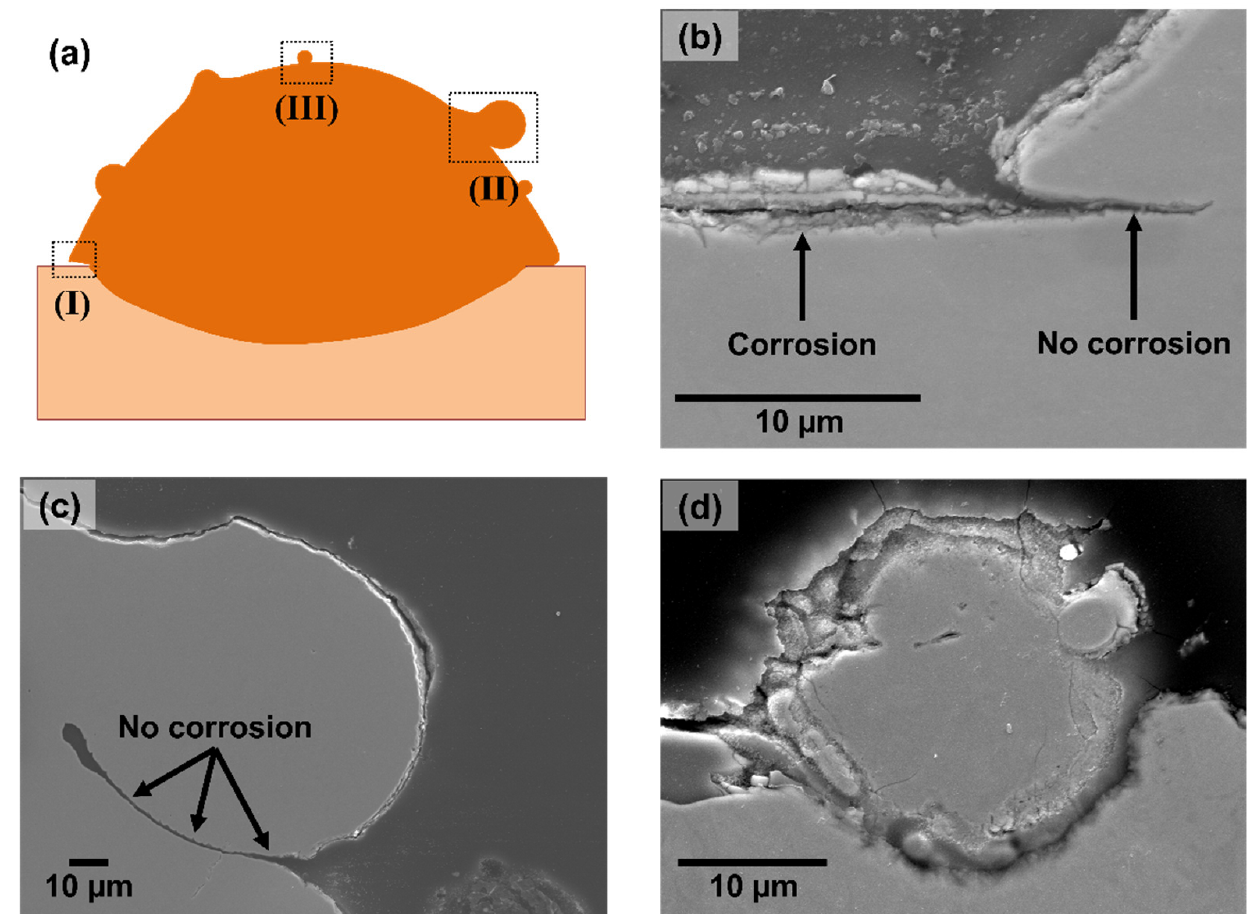
Figure 11. Images of samples after immersion in 3.5 wt.% NaCl for 1 week. ( a ) Schematic of the cross section of a typical printed clad in which specific features are highlighted: I—( b ) region at the border of the deposited clad in which a gap exists due to insufficient fusion between the deposited clad and the base plate (corrosion is not seen at the gap but rather next to the clad, at the heat-affected zone), II—( c ) region at the surface of the printed clad with a partially un-melted powder particle of average size or larger (no corrosion was observed around these relatively larger particles), and III—( d ) region at the surface of the printed clad in which a small, partially un-melted powder particle is visible (corrosion around these small particles was systematically observed).